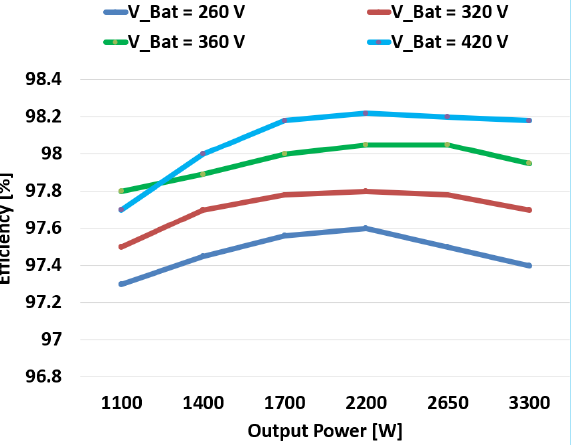
Figure 20. Efficiency plots during function I operation with wide range of input voltage variation.